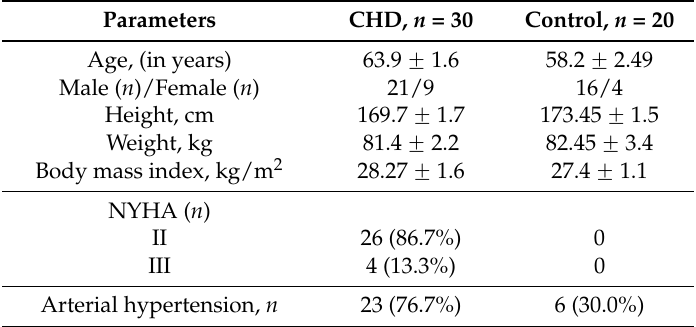
Table 1. Characteristics of participants in coronary heart disease (CHD) and control groups.